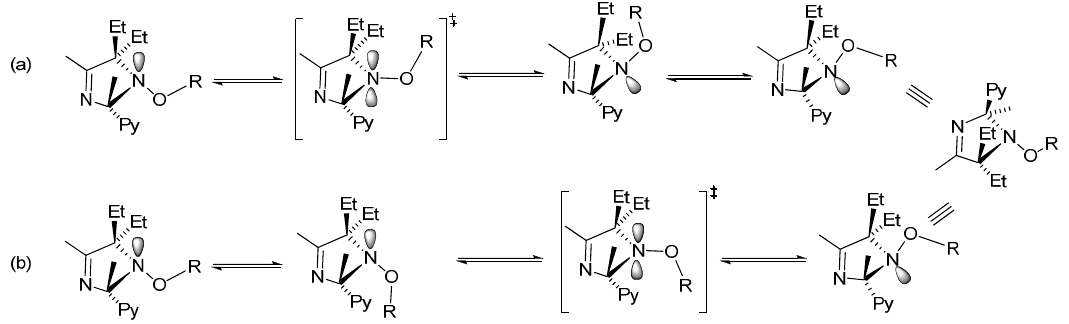
Scheme 3. Process involving either ( a ) nitrogen inversion and N–O bond rotation or ( b ) N–O bond rotation and nitrogen inversion and expected transition state (TS) for the nitrogen inversion event.